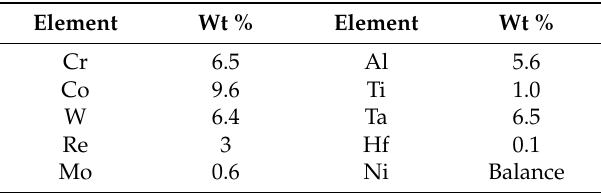
Table 1. CMSX-4 alloy nominal